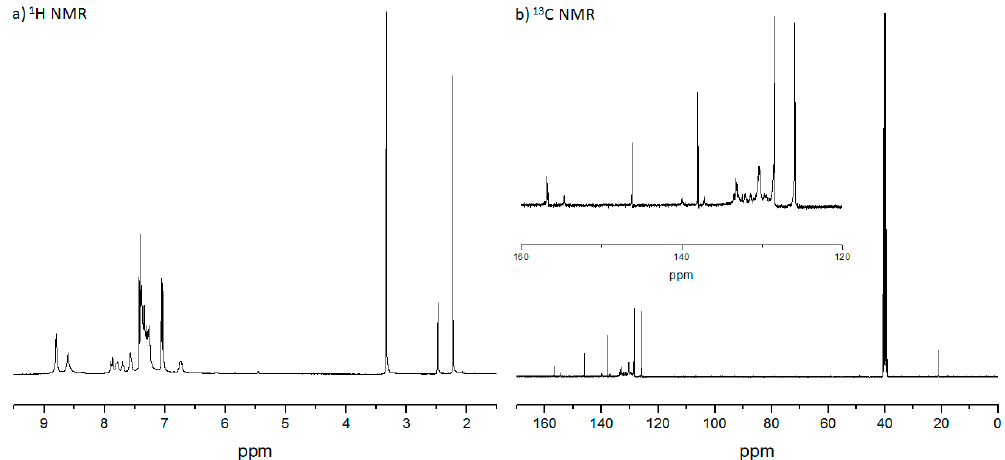
Figure 3. 1 H and 13 C NMR spectra of ionic polymer P-1 in d 6 -DMSO taken at room temperature.